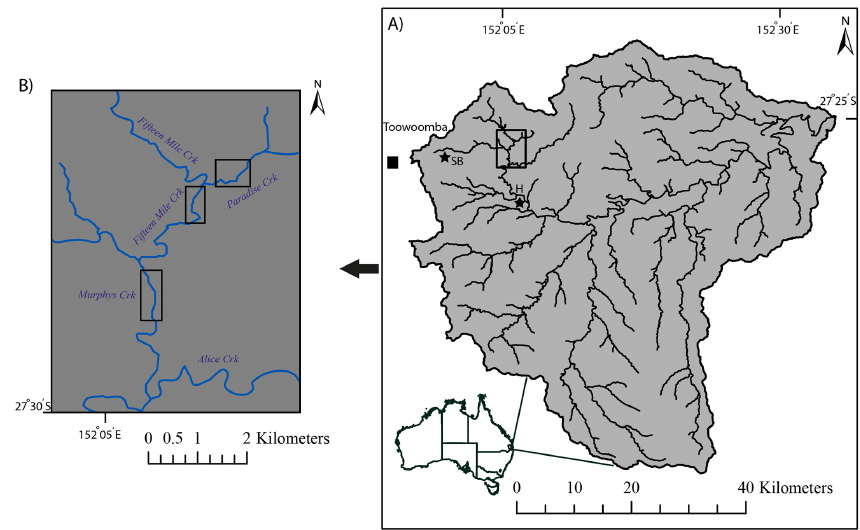
Figure 2. (a) Location of the Lockyer Valley catchment in southeast Queensland, Australia, including the location of the two gauges used in the study (stars): Spring Bluff (SB) and Helidon (H) and location of the study area (boxed region). (b) Study area in the upper valley showing the three main creeks utilised in the field